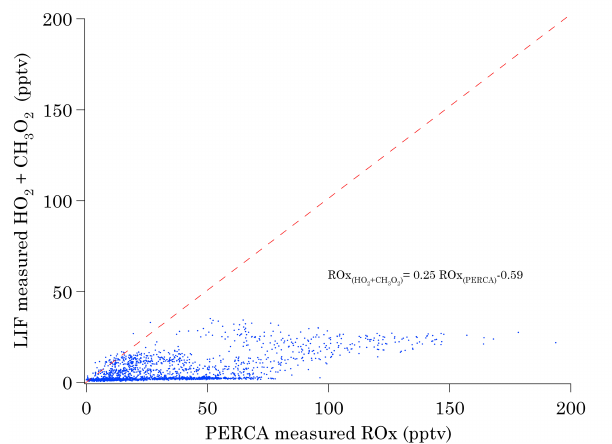
Fig. 10. Results from the chemical box model for daytime HO 2 and CH 3 O 2 , obtained by constraining the model with the measurements of non-radical species.